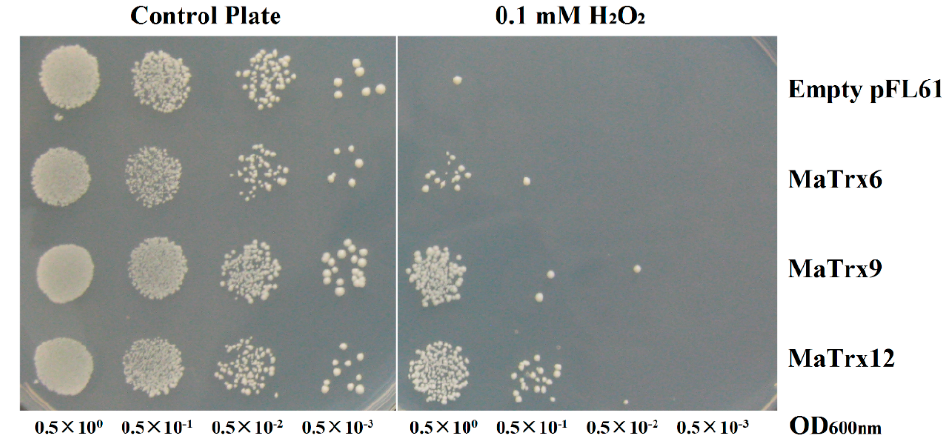
Figure 6. Functional complementation of Trx1 Δ Trx2 Δ yeast cells by heterologous MaTrx6, MaTrx9 and MaTrx12, respectively. Yeast expressing MaTrxs were grown to a density of 10 7 cells·mL − 1 . 30 μ L of serial dilutions (OD 600nm = 0.5 × 10 0 , 0.5 × 10 − 1 , 0.5 × 10 − 2 , 0.5 × 10 − 3 ) were plated on SC-Ura medium without (control plate) or containing 0.1 mM hydrogen peroxide, and the empty pFL61 vector was used as control.